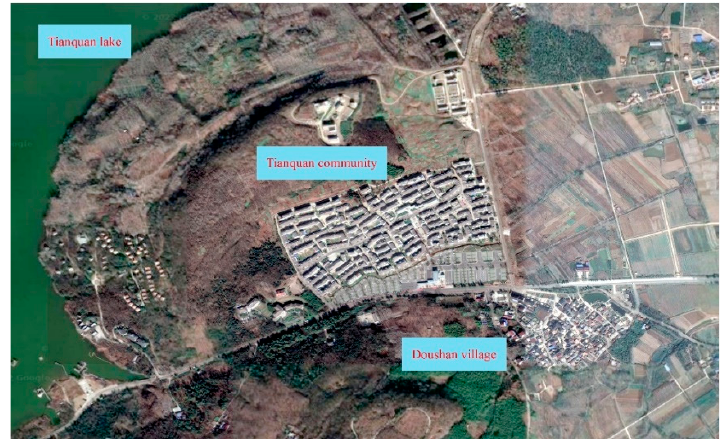
Figure 4. Satellite image of the location distribution of research areas.